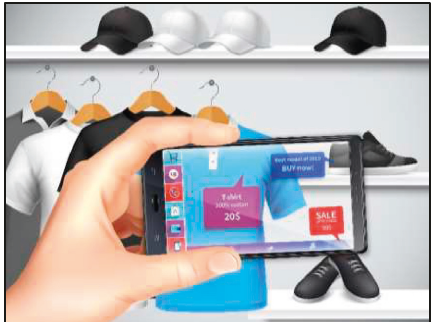
Figure 4: Depiction of how AR technology brings objects in the real world to life to give more information about them to the users [30].